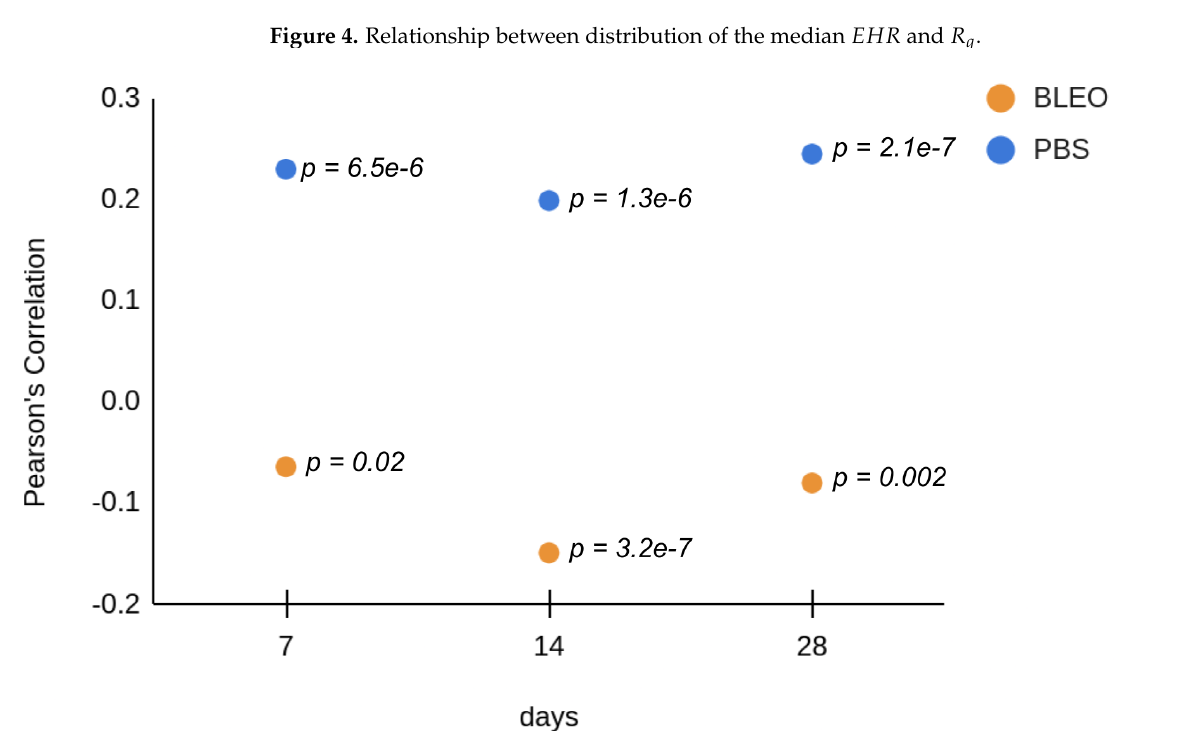
Figure 5. Pearson’s correlation between median values of EHR and R q